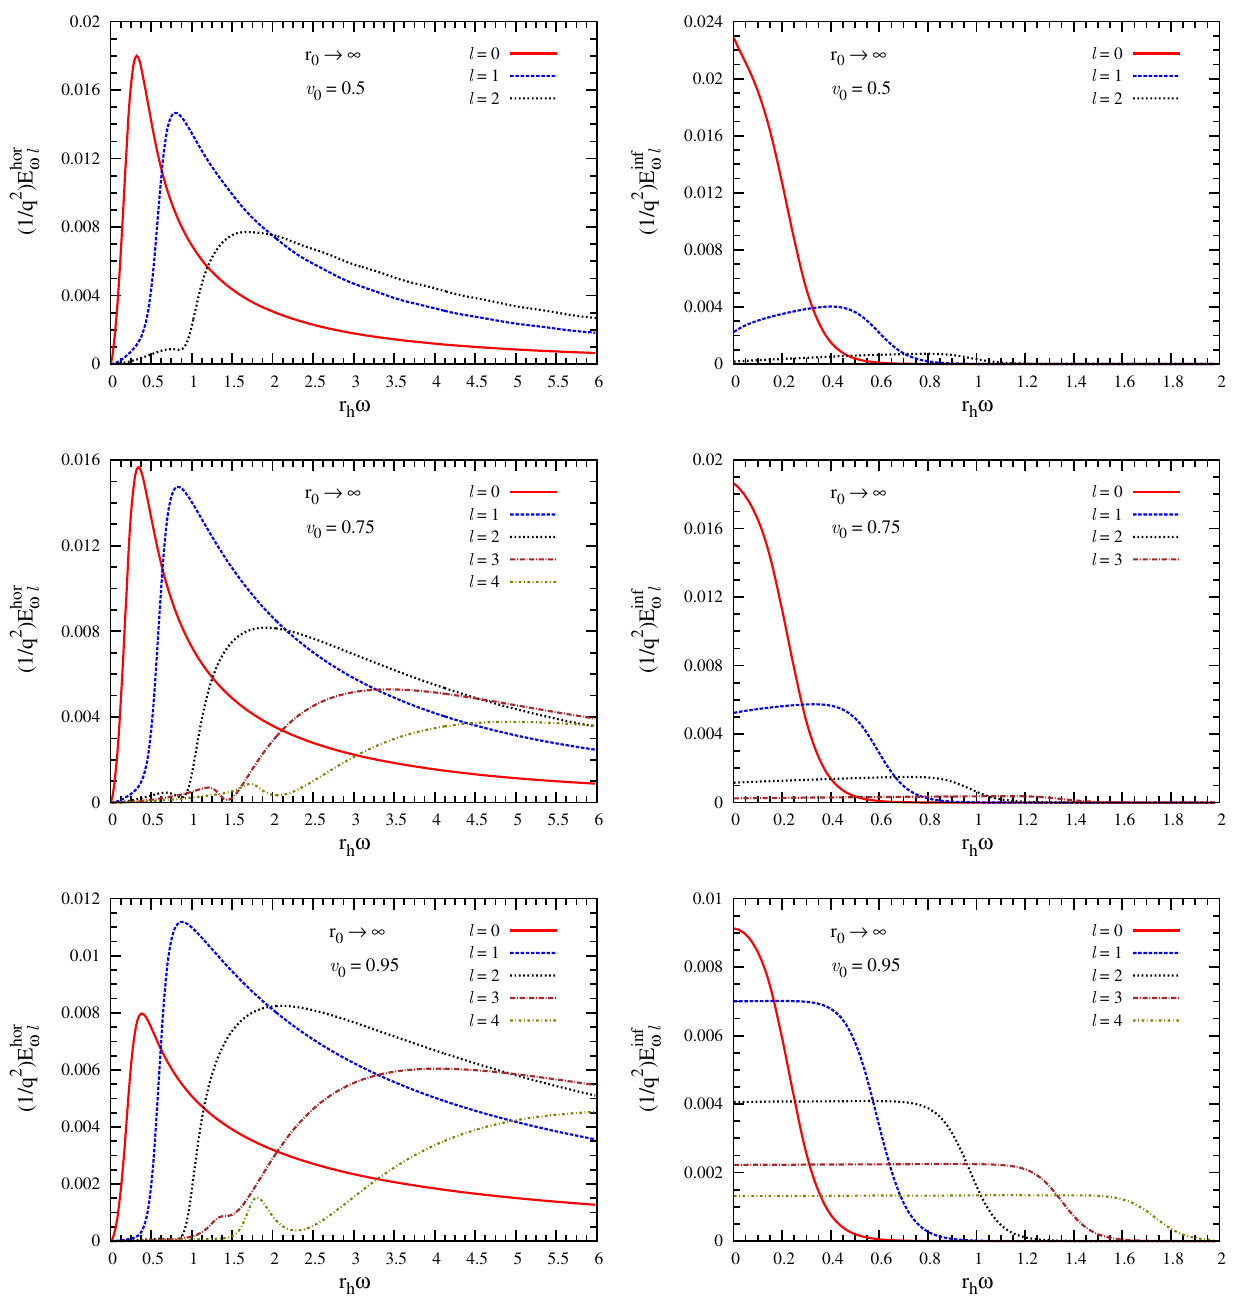
Fig. 2 Numerical estimates of the spectra of the emitted energy, E hor ω and (38) for the radial infall of a source from spatial infinity ( r 0 → ∞ ), l with the initial velocity v 0 = 0 . 5 (plots at the top), v 0 = 0 . 75 (plots in (plots on the left) and E inf ω (plots on the right) as functions of ω l the middle) and v 0 = 0 . 95 (plots at the bottom) for selected values of the multipole number, obtained from Eqs. (34) same results by using Eq. (35), instead of Eq. (34), and setting not decrease as the multipole number l increases unlike the B = 0, because the boundary term (36) vanishes.] We note energy emitted to infinity. This behavior of the spectra E hor ω , (plots is similar to that of the corresponding spectrum for the grav- that the spectra of energy emitted to the horizon, E hor ω l on the left in Fig. 2) starts from zero (at ω = 0), reaches a itational radiation [5]. It reflects the fact that the source has maximum and then slowly decreases to zero (for high val- infinite self energy due to the Coulomb-like potential and ues of ω ). Note that the energy emitted to the horizon does that the region of large energy density passes through